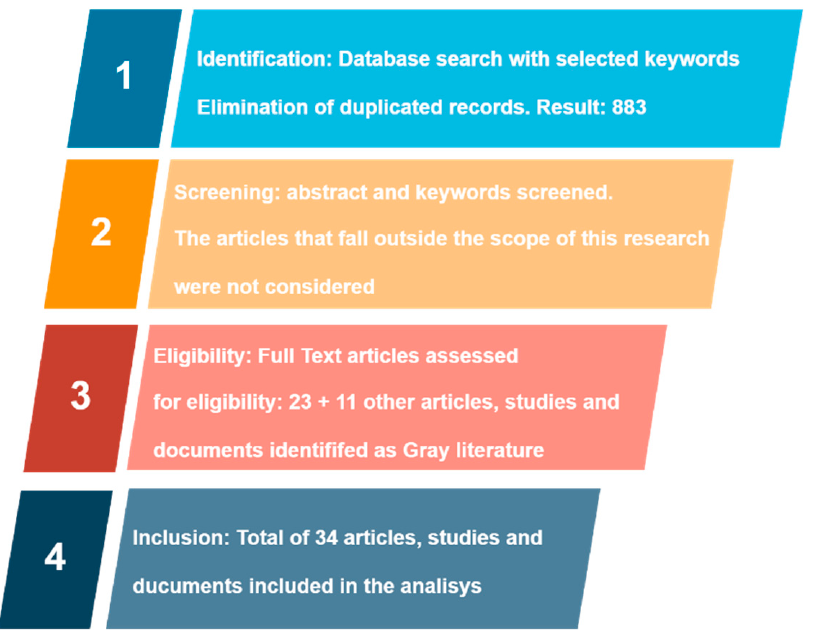
Figure 1. Literature Review Flowchart.